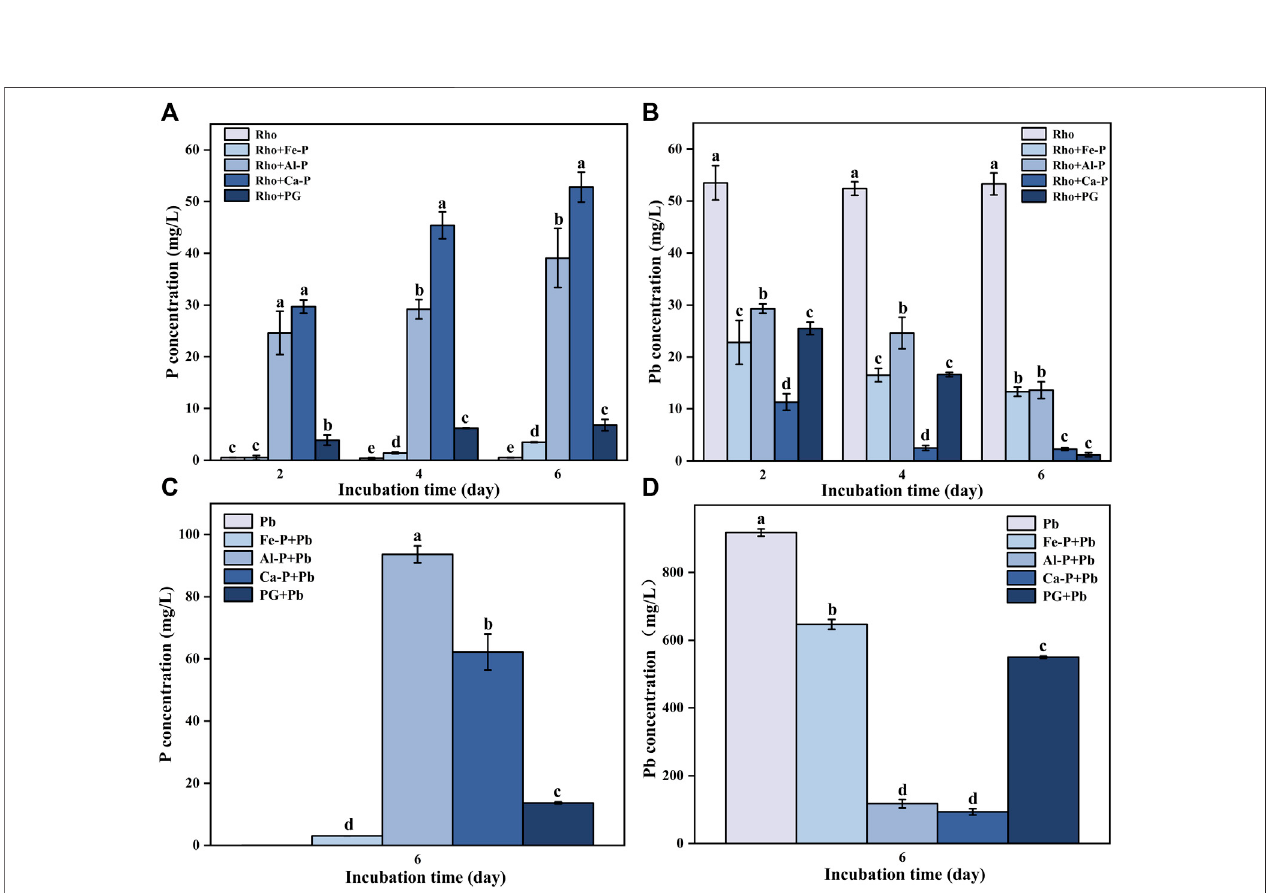
FIGURE 2 | P concentration (A,C) and Pb concentration (B,D) in each treatment during the incubation time (2, 4, and 6 days). The error bars represent the standarddeviations ofthreereplicates.Thesigni fi cantdifferences amongthetreatmentswereidenti fi edbyTukey ’ shonestly signi fi cantdifference test( p < 0.05) via one- way